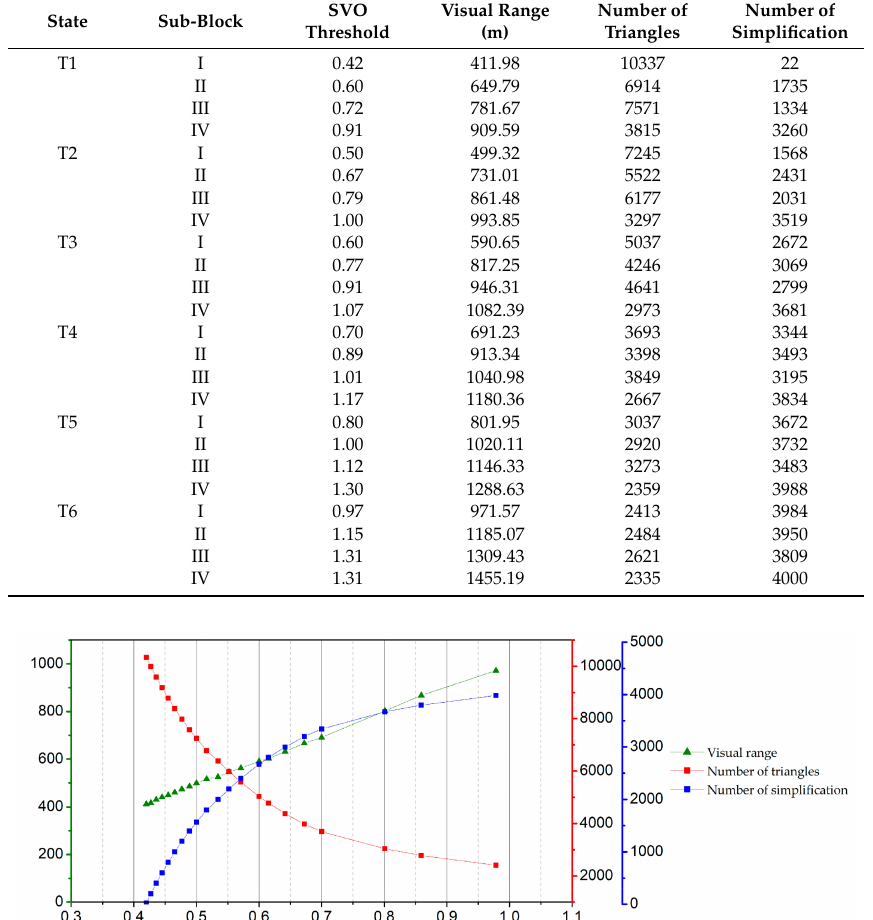
Table 2. Experimental parameters of the di ff erent sub-blocks in T1~T6 time states: the sub-block number, SVO threshold, visual range from the viewpoint of each sub-block, number of triangles, and number of simplifications, corresponding to the primitive mesh.